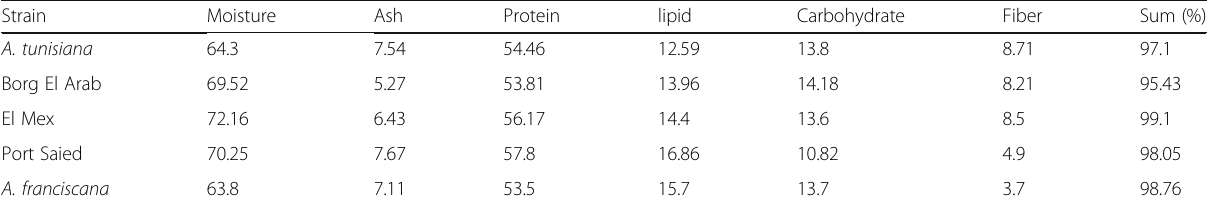
Table 1 Average proximate composition (in % dry basis) mg/g DW of the newly hatched different Artemia strains Strain Moisture Ash Protein lipid Carbohydrate